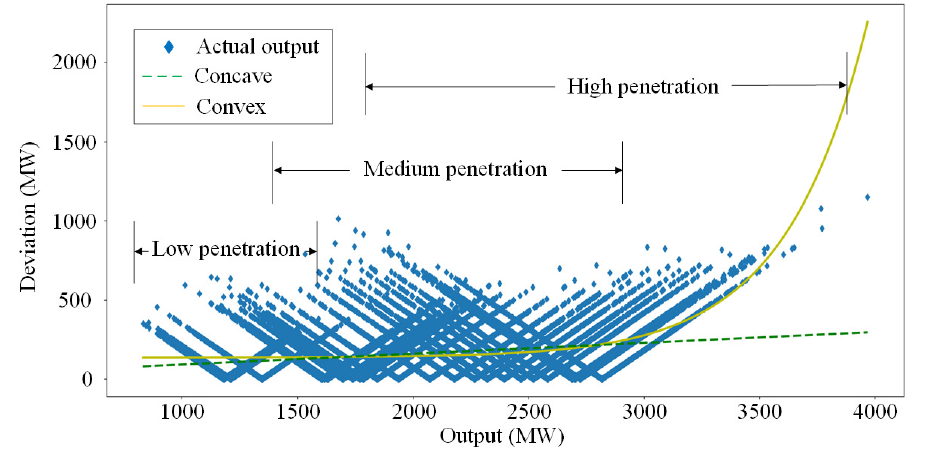
Figure 5. Fitting functions of risk–utility.